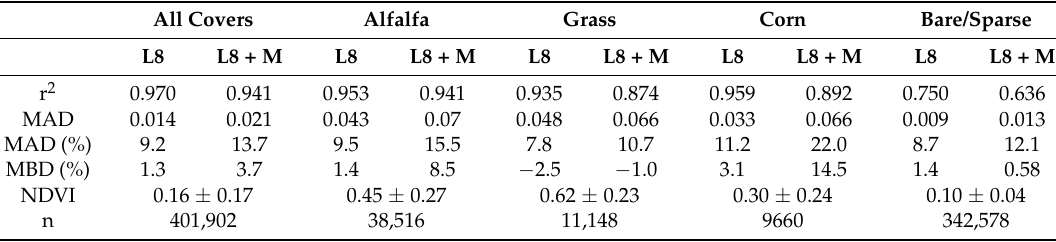
Table 3. Overall (i.e., Planet DOY 318, 352 and 001) NDVI prediction results on a cover specific basis. Results based on the Landsat-only (L8) and MODIS informed (M) processing streams are reported in separate columns (i.e., L8 and L8 + M). The statistics are based on Planet data resampled to 30 m, and are reported for the full set of data points (i.e., 99%). The number of pixel samples (n), and average NDVI and standard deviation of each cover type are also